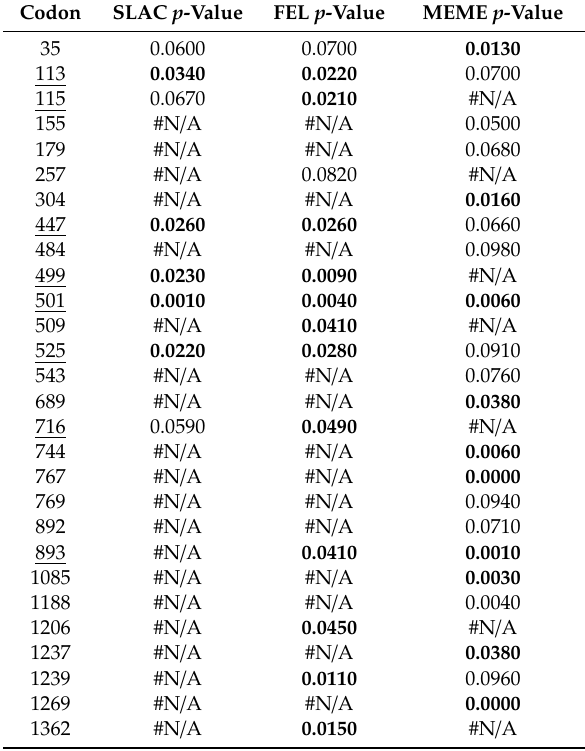
Table 3. Amino acid sites detected to be under positive selection (with p -values < 0.1) through either of the selection methods (SLAC, FEL, and